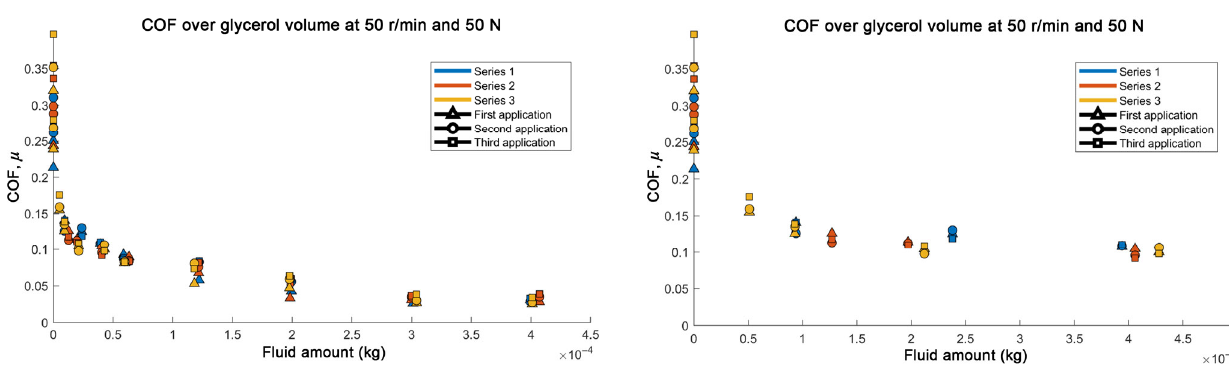
Fig. 10 COF vs. amount of fluid for the system with the finely filed pin.